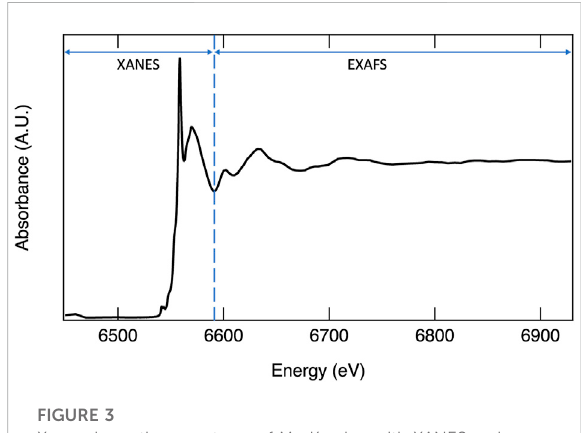
FIGURE 3 X-ray absorption spectrum of Mn K-edge with XANES and EXAFS regions identi fi